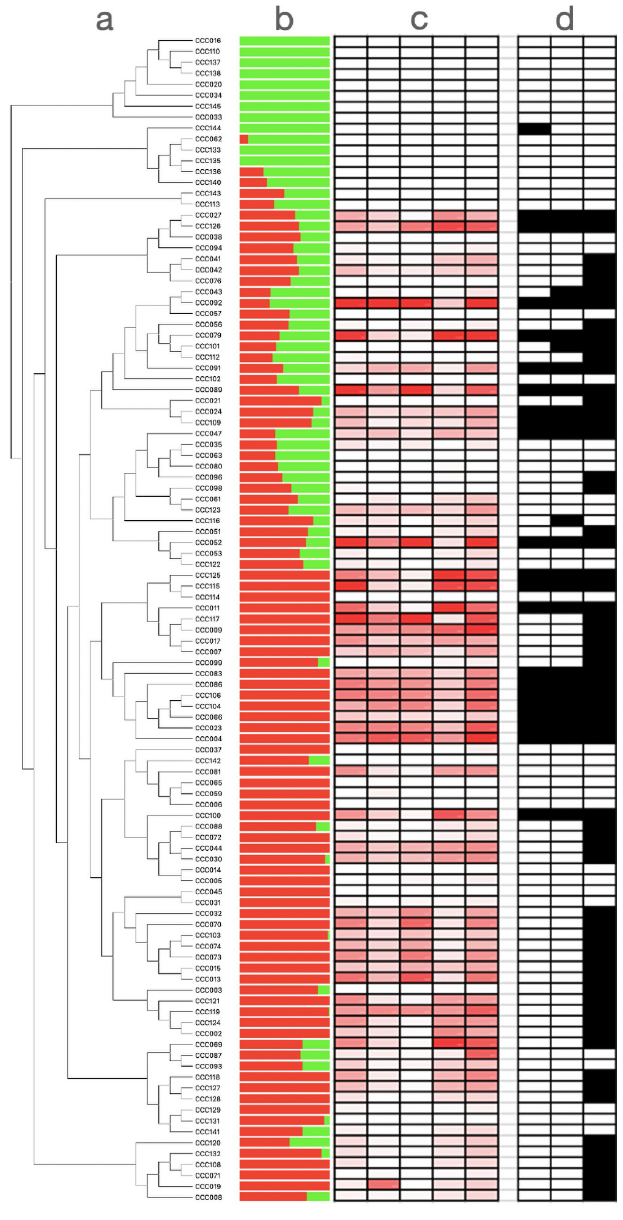
Fig 2. Genetic and metabolic variation shown in Solanum tuberosum group Phureja. (a) Neighbor joining phylogeny conducted with all SNPs used in GWAS. Names on the top of the branches correspond to the names of potato accessions from the Colombian Core Collection (CCC). (b) Results of Admixture with a K = 2. (c) Anthocyanin content: Darker colorations are associated with darker concentrations of the compound. 1: Delphinidin; 2: Cyanidin; 3: Petunidin; 4: Pelargonidin; 5: Peonidin. (d) Genotypes at significant SNPs from Chromosome 10. The allele associated to a darker coloration (in homozygous or heterozygous state) is in black. 1: pos 52,004,868; 2: pos 52,261,553; 3: pos